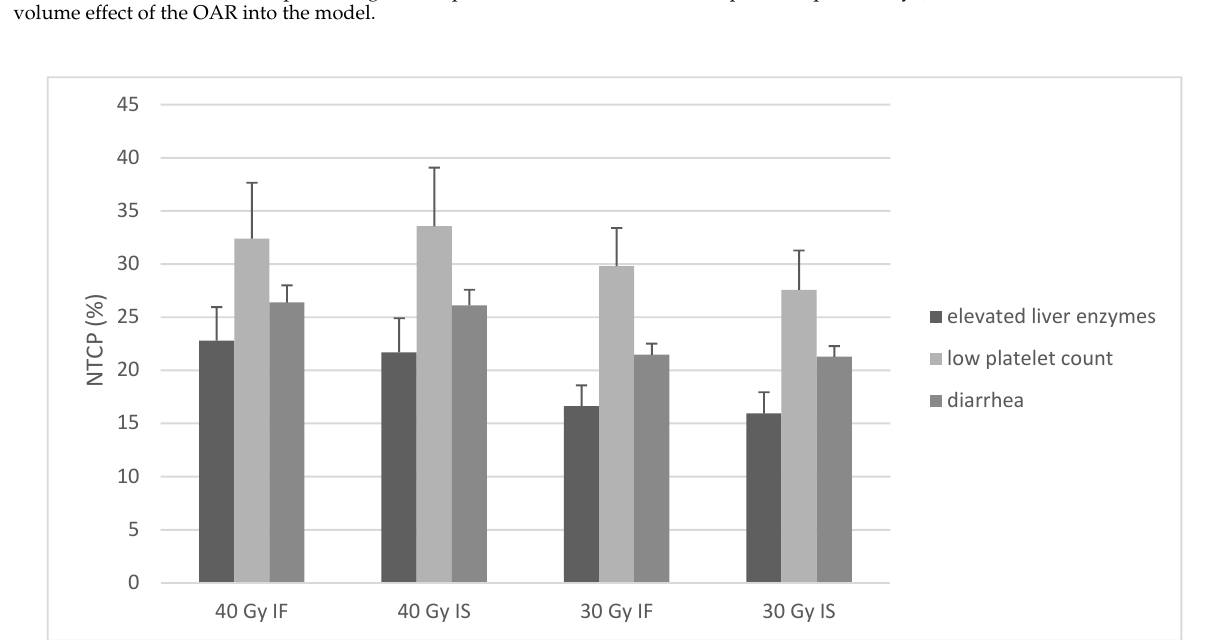
Figure 2. Median NTCPs (%) and standard deviation as calculated with the LKB model using data from the cohort of 18 patients, their CT = computed tomography, and follow-up data on toxicities. Table 4. Cohort toxicity rates vs. estimated